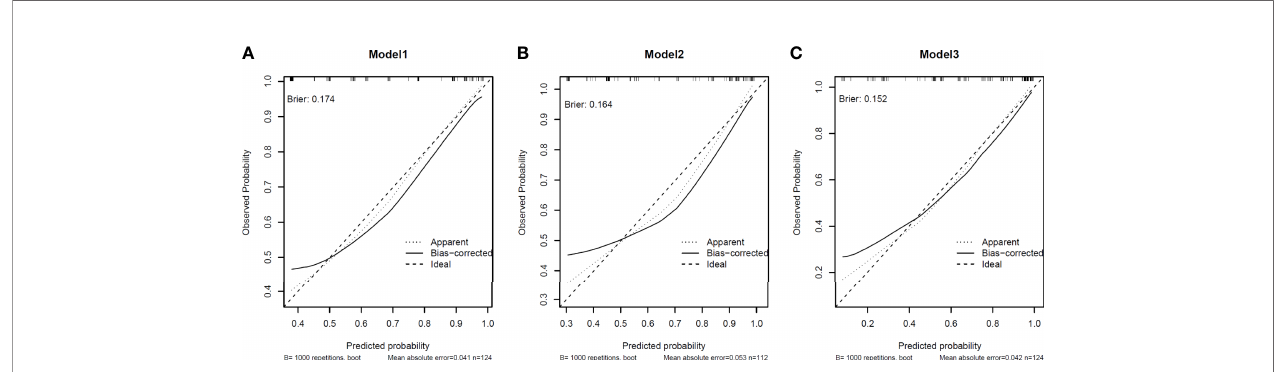
FIGURE 3 | Calibration of the models. Model calibration was assessed by in-sample calibration and bias-corrected calibration with 1000 bootstrap resampling procedures. Brier score was applied as the index of model calibration. (A) In model 1, clinical variables only model displayed brier scores of 0.174. (B) In model 2, clinical variables + CEA model displayed brier scores of 0.164. (C) clinical variables + sPDL2 and sCD27 displayed brier scores of